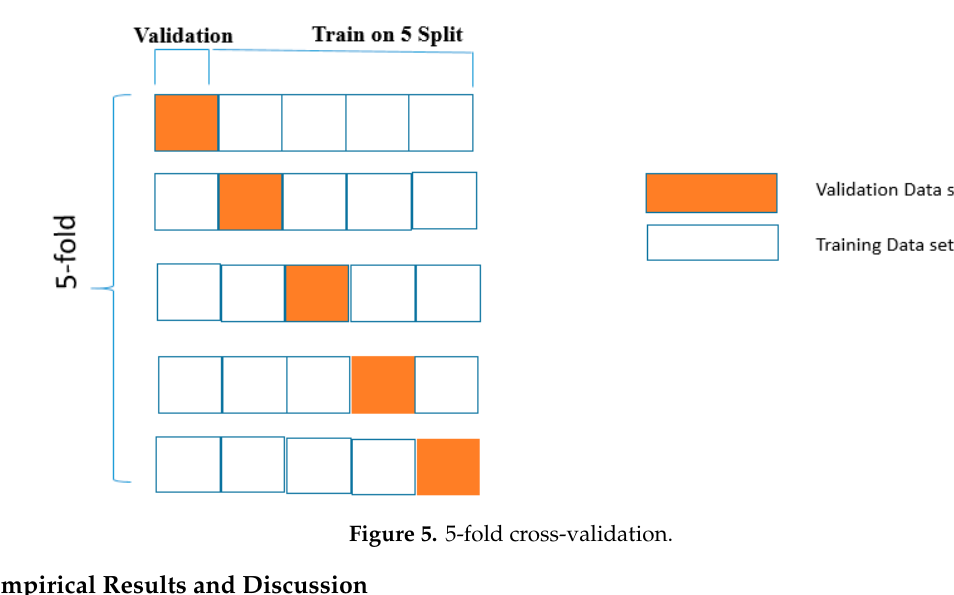
Table 2. List of features with positive weights assigned by the relief algorithm.